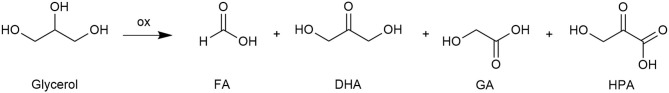
Products of glycerol oxidation.